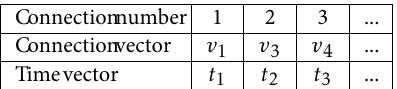
Table 1. Anexampleofsatellite connectiondata withthreerows: Connection number , Connection vector and Time vector .